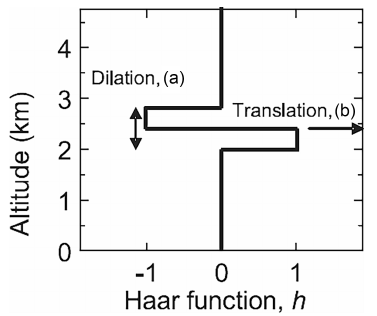
Figure 1. Haar’s function defined by the dilation (a) and the trans- lation (b) .